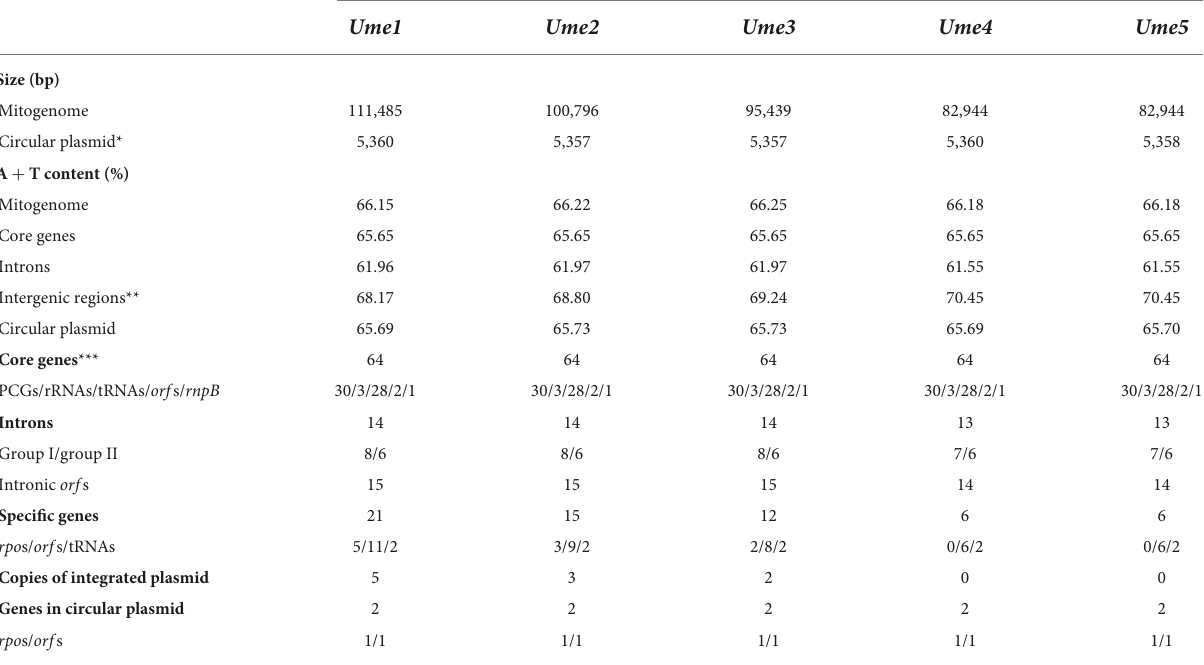
TABLE 1 General features of mitochondrial genomes and circular plasmids in Ulva meridionalis . General features